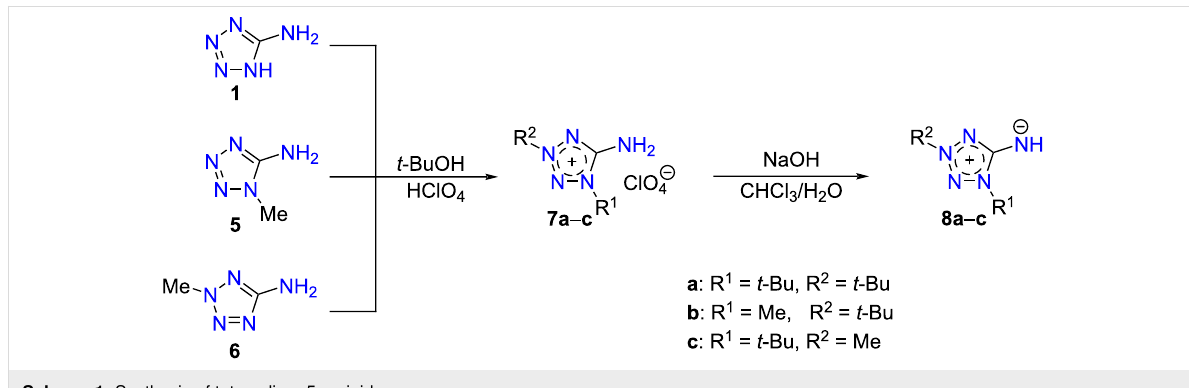
Scheme 1: Synthesis of tetrazolium-5-aminides.